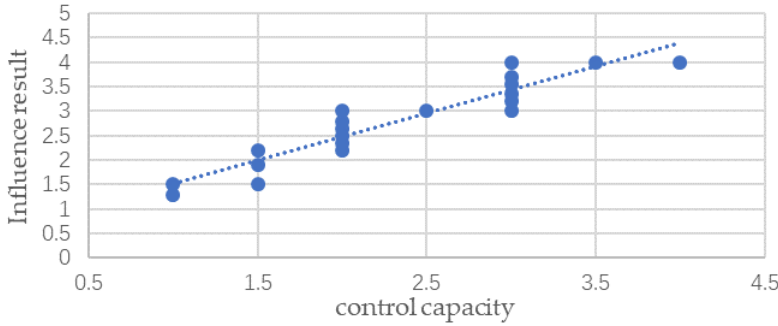
Figure 7. Scatter diagram of control capacity vs. influence results.